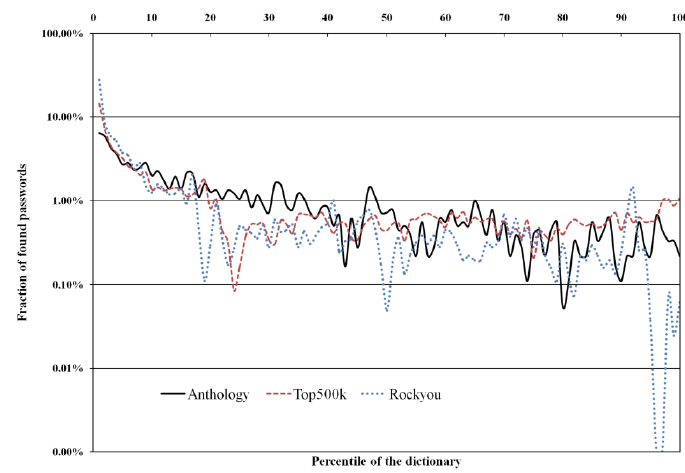
Figure 2. Distribution of matched passwords in sorted dictionaries.